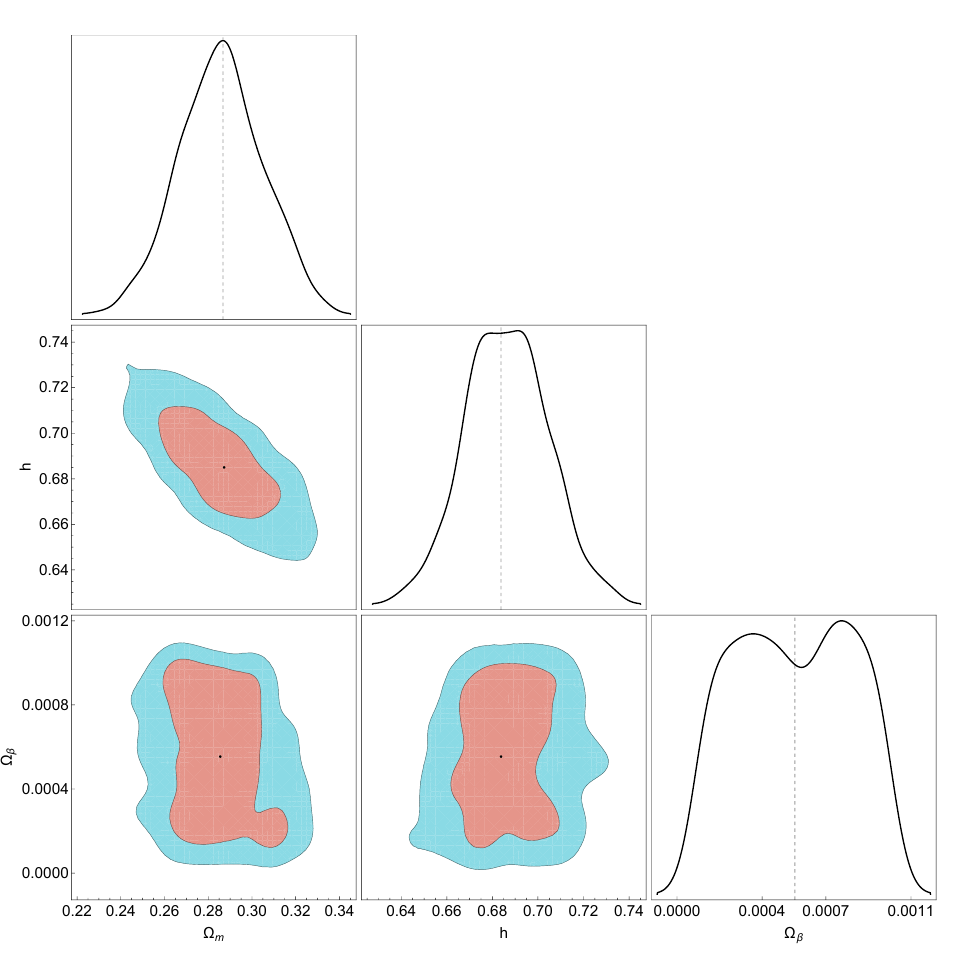
Figure 1 . The 68 . 3% and 95 . 4% confidence contours between parameters for the Hairless BH case and their 1D marginalized likelihood. The vertical dashed lines and black dots indicate the mean MCMC values at ( Ω m , h , Ω β ) = ( 0 . 2855 , 0 . 6837 , 5 . 5431 × 10 − 4